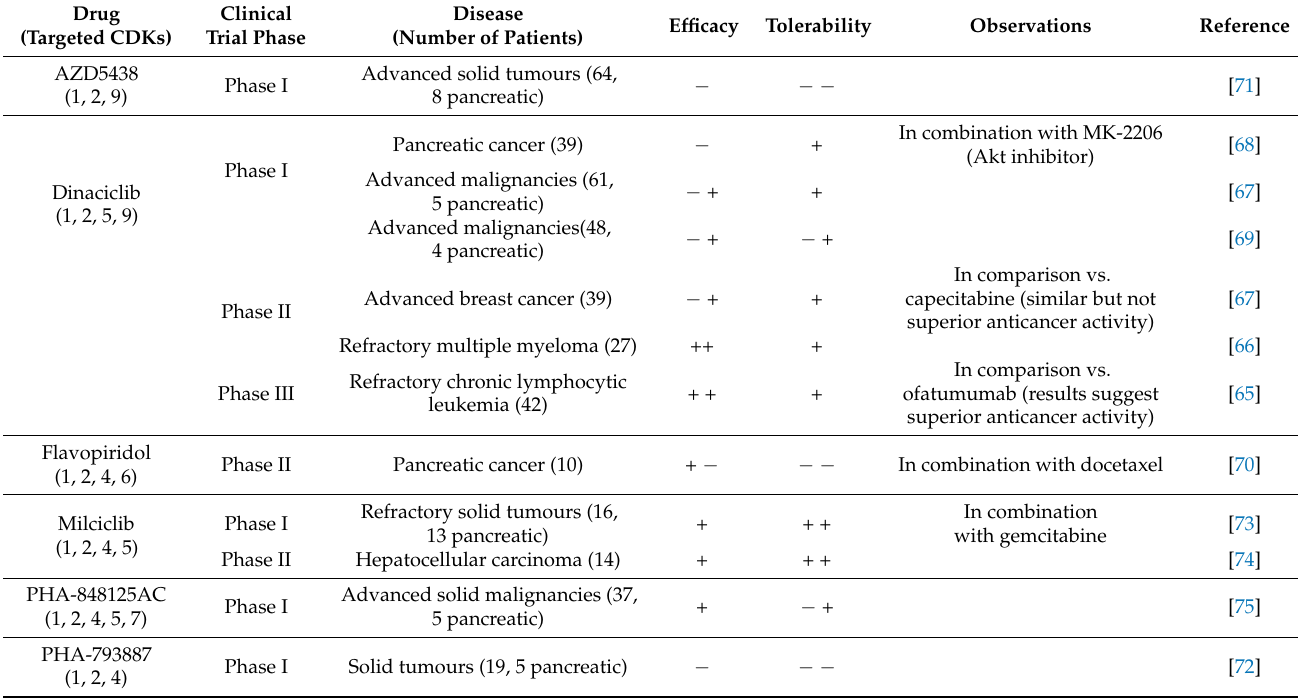
Table 1. Clinical trials testing different CDK1-inhibiting